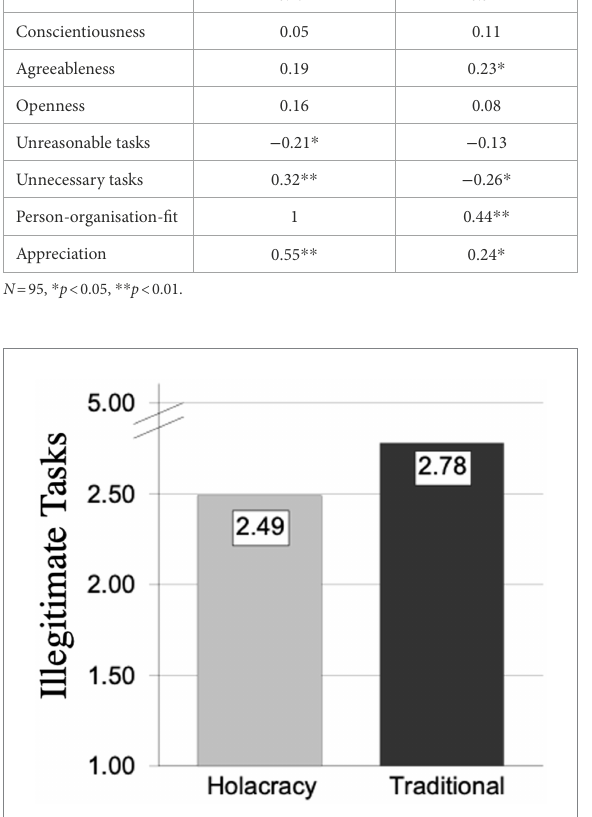
FIGURE 1 Main values of illegitimate tasks in holacratic organisations and traditional organisations.